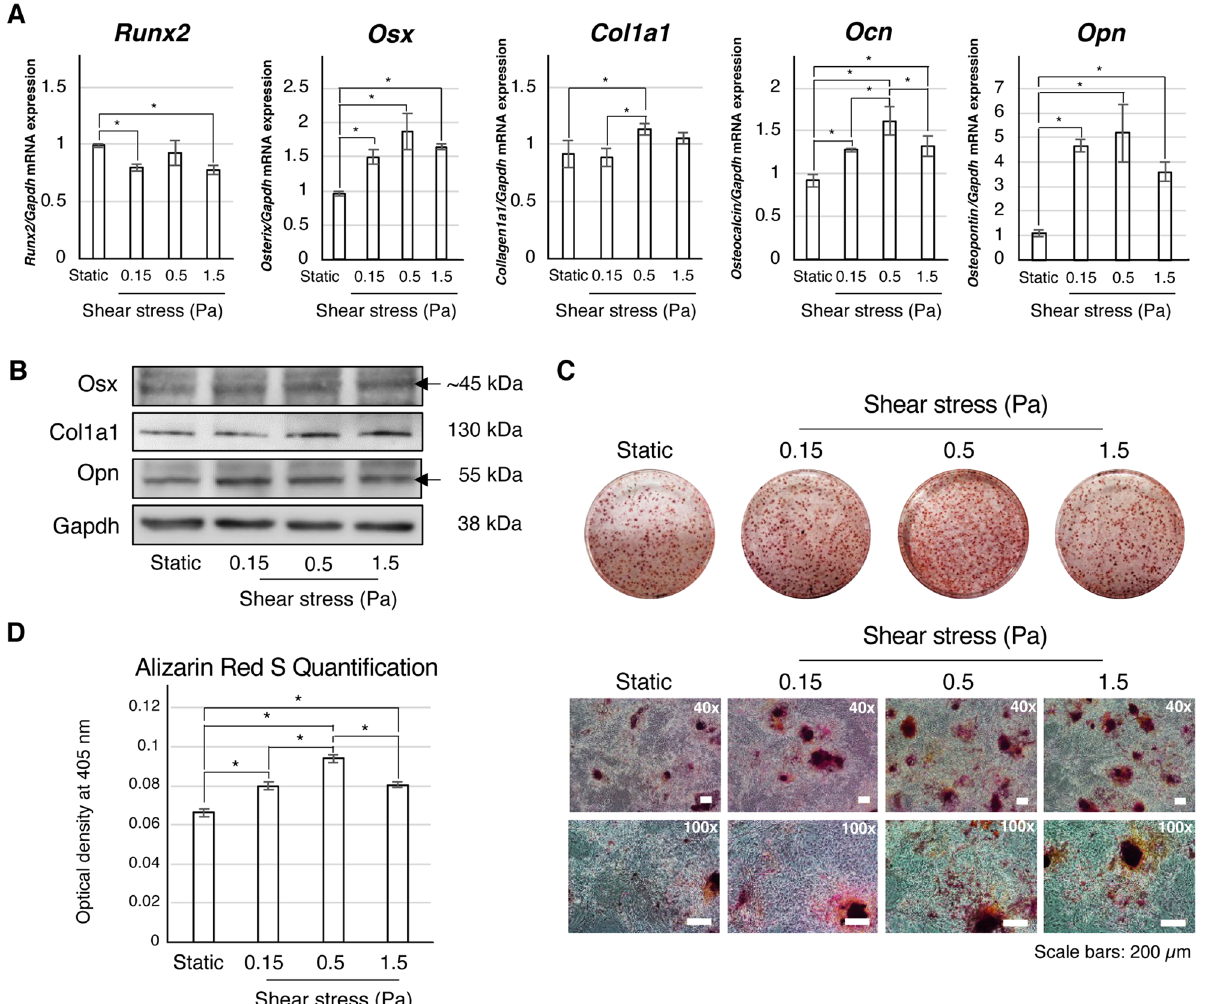
Figure 2. Continuous shear stress enhanced the osteogenic differentiation of iPSCs in a force-independent manner. iPSCs were cultured in OS medium with 0.15, 0.5, and 1.5 Pa of shear force application for 48 h prior to ( A ) real-time RT-PCR, ( B ) western blotting, and ( C ) Alizarin Red S staining analyses. Static culture of iPSCs in Os medium was collected for evaluation at the same time point as a control. ( A ) Real-time RT-PCR was performed to detect the expression of osteogenic genes Runx2 , Osx , Col1a1 , Ocn , and Opn . Gapdh was used as an internal control. *: P < 0.01, ANOVA with Tukey’s multiple comparison test. Data represent the mean ± SD (n = 3). ( B ) Western Blotting analysis of osteogenic markers Osx, Col1a1, and Opn. Gapdh was used as a loading control. Original blots are presented in Supplementary Fig. 5. ( C ) Positive Alizarin Red S staining is shown in red. The magnifications of upper and lower panels are 40 × and 100x, respectively. Scale bars: 200 μm. ( D ) Alizarin Red S staining was quantified based on absorbance at 405 nm. *: P < 0.05, ANOVA with Tukey’s multiple comparison test. Data represent the mean ± SD (n =